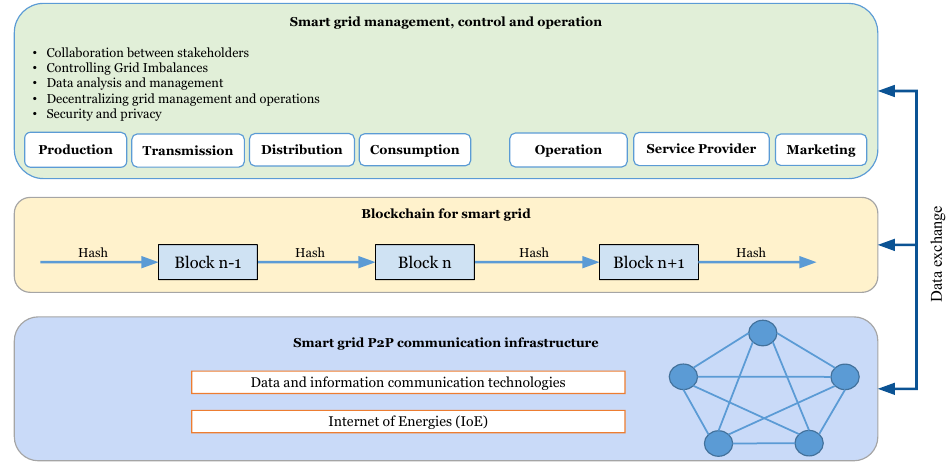
Figure 3. Blockchain infrastructure for smart grid management, control, and